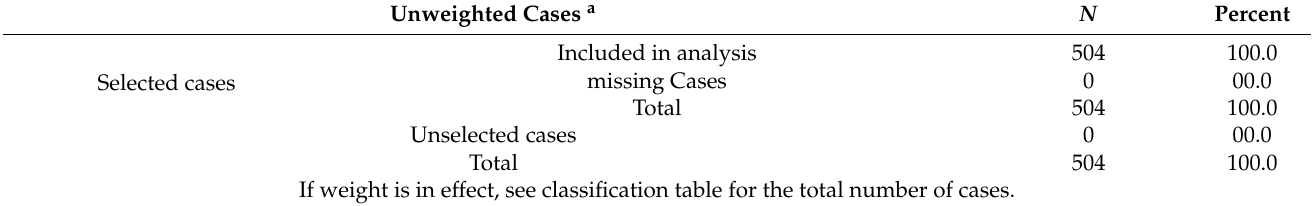
Table 5. Logistic regression output for motivation, case processing summary.